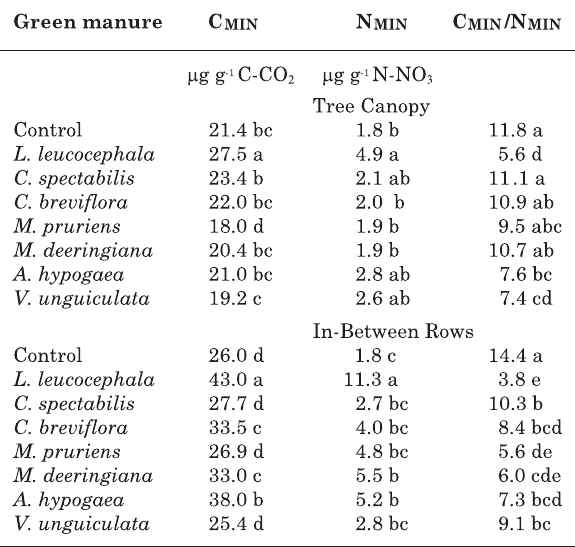
Table 3. Carbon and N mineralization in 24 days and the C/N mineralization ratio under the tree canopy and in-between rows as affected by different legume green manures